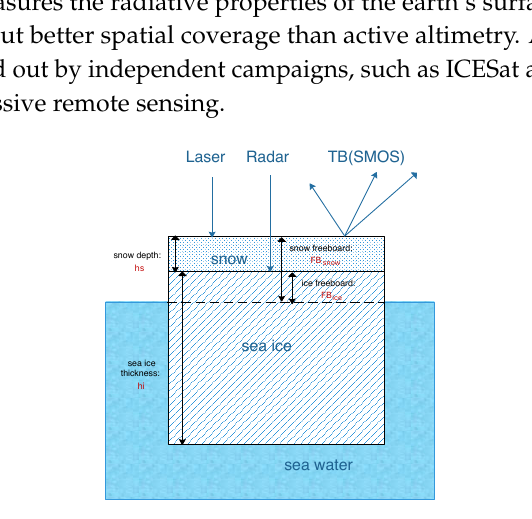
Figure 1. Schematic diagram of active and passive remote sensing of the sea ice cover. Sea ice parameters ( hi and hs ), as well as the directly observed values of freeboard ( FB ice amd FB snow ) and brightness temperature ( TB ) are also